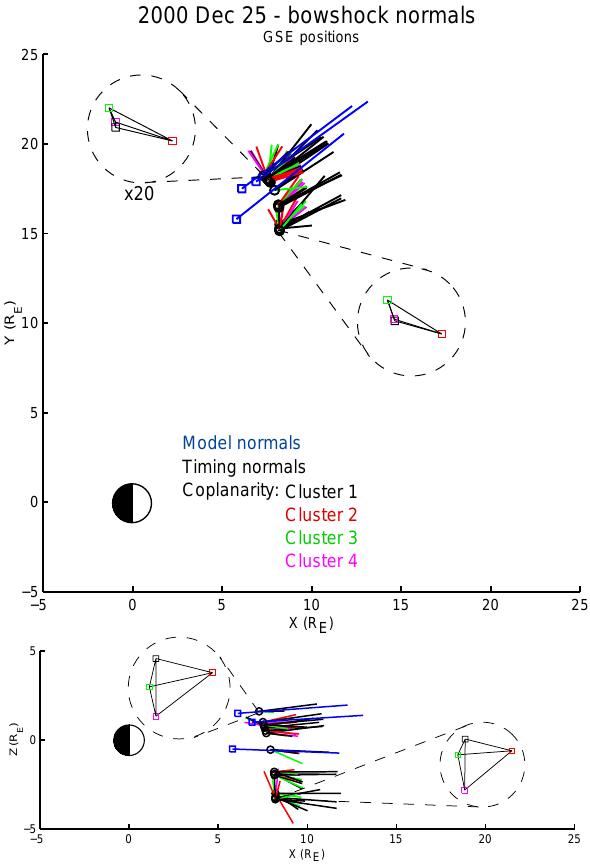
Fig. 2. Bowshock normals calculated from four spacecraft timings. Normals are plotted as long black lines extending from the observed bowshock locations, in (top) the X − Y and (bottom) X − Z planes. Shorter coloured lines show coplanarity normals calculated using magnetic field data from all four spacecraft. Long blue lines show calculated model normals. Relative spacecraft positions are shown for the start and end of the period of interest, expanded 20 times larger than